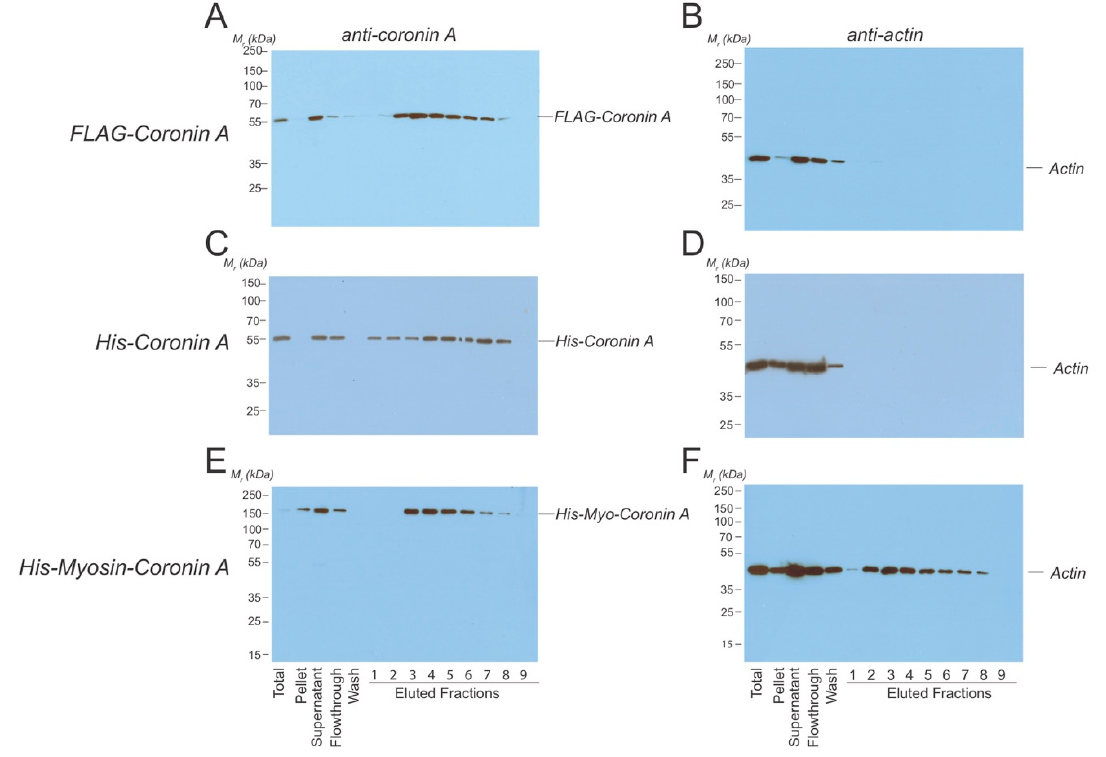
Figure 3. Co-purification of Dictyostelium coronin A and actin. Dictyostelium cells expressing the constructs indicated were lysed in lysis buffer and homogenized using a glass Tenbroek homogenizer followed by low speed centrifugation. ( A , B ). FLAG-CorA was purified using an anti-FLAG column. Fractions were collected, separated by SDS-PAGE, and tested for the presence of coronin A ( A ) and actin ( B ) by Western blotting. ( C , D ). Coronin A fused to a Histidine-tag was purified using Nickel beads. Cells were lysed in the absence of NaCl, fractions were collected, separated by SDS-PAGE, and tested for the presence of coronin A ( C ) and actin ( D ) by Western blotting. ( E , F ). Coronin A fused to a Histidine-tagged myosin heavy chain fragment was purified using Nickel beads. Fractions were collected, separated by SDS-PAGE, and tested for the presence of coronin A ( E ) and actin ( F ) by Western blotting. Shown are representative results from at least three independent experiments.